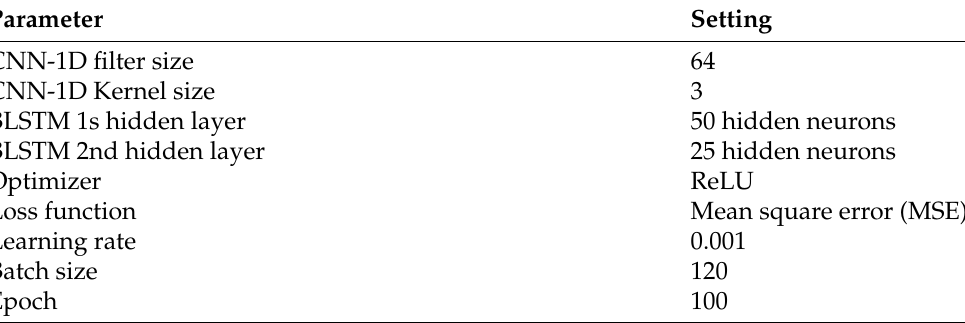
Table 1. Parameter settings of the proposed